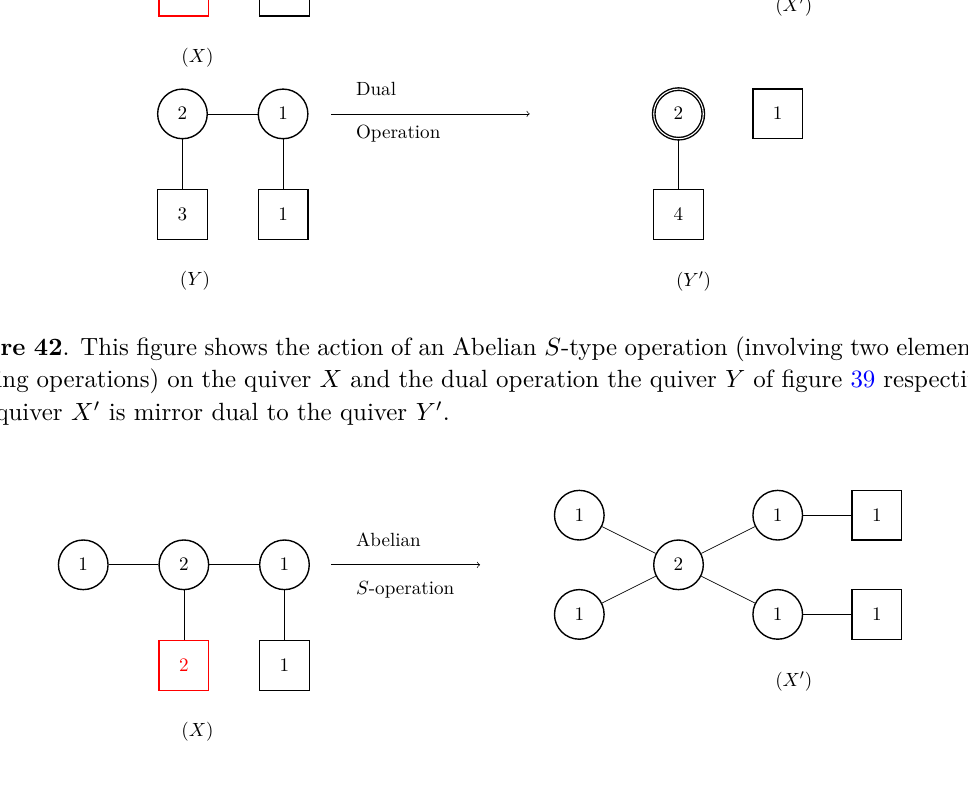
Figure 43 . This figure shows the action of an Abelian S -type operation (involving an elementary flavoring-gauging and an elementary gauging operation) on the quiver X on the